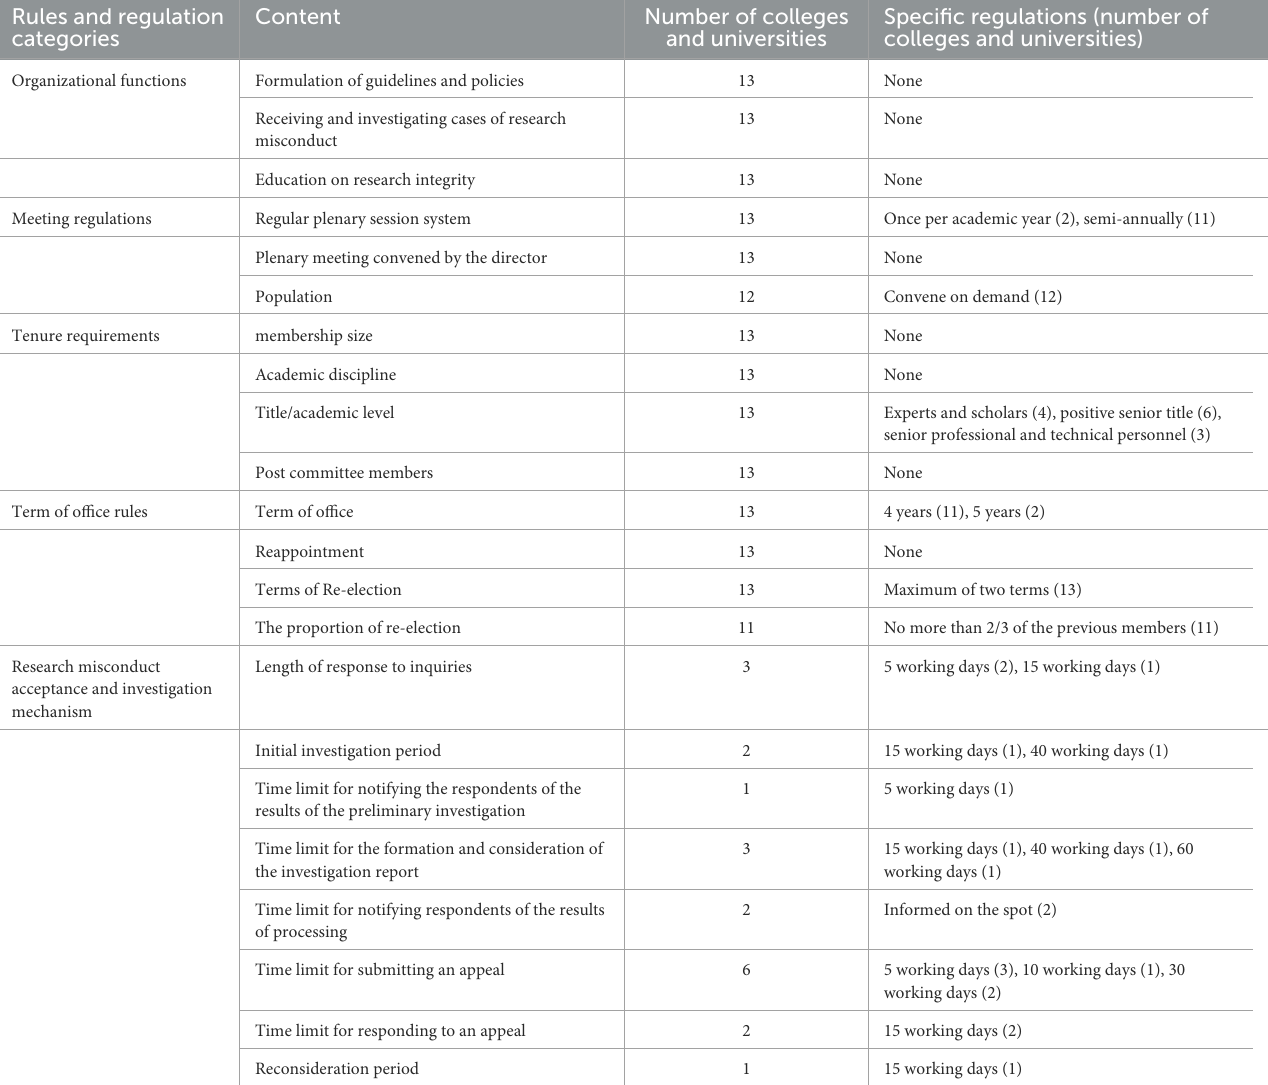
TABLE 6 Research on statutes of specialized institutions for RI management in